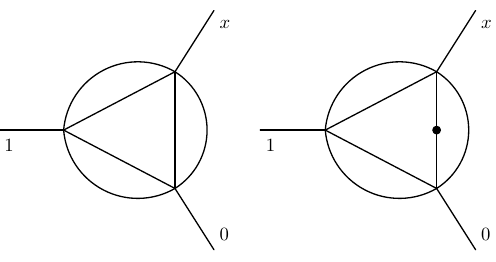
Figure 2 . Master integrals j 1 and j 2 of eq. (3.4). For x = 0 or x = 1 the number of master integrals in this sector reduces to